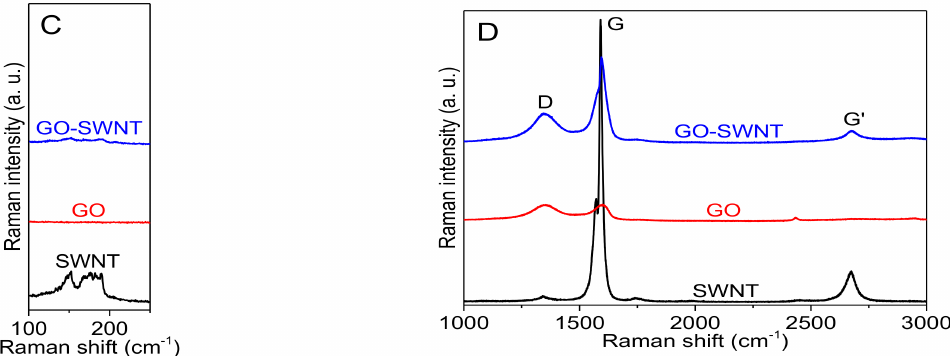
Figure 1. ( A ) UV-vis absorbance of diluted GO and GO-SWNT (weight ratio of 10:1) dispersions. Pure SWNT solution (weakly oxidized by nitric acid) is shown for comparison. The inset photo displays GO-SWNT (left) and GO (right) dispersions. ( B ) Absorbance of GO-SWNT dispersion for different time periods. ( C , D ) Raman profiles of GO-SWNT dispersion (weight ratio of 10:1), GO and SWNT.